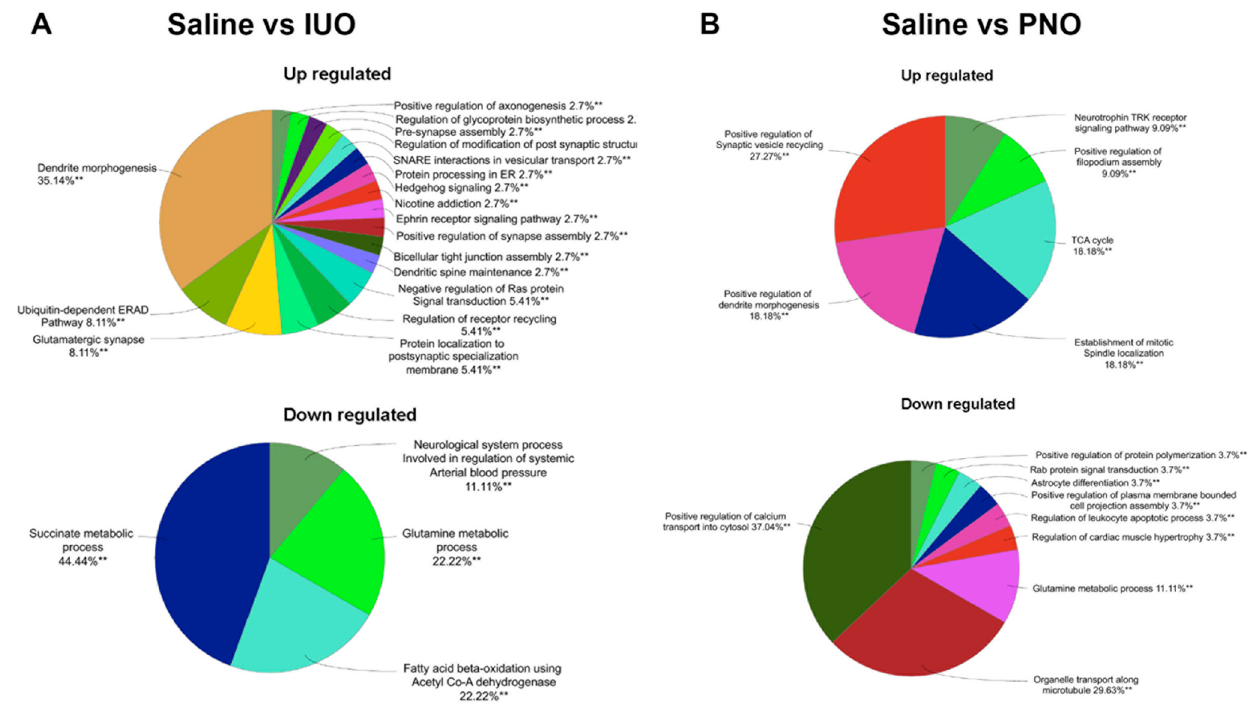
Figure 4. ClueGO analysis shows the different biological processes in the IUO ( A ) and PNO ( B ) groups. Group term p -value is represented by asterisks for each category. ** p < 0.01.